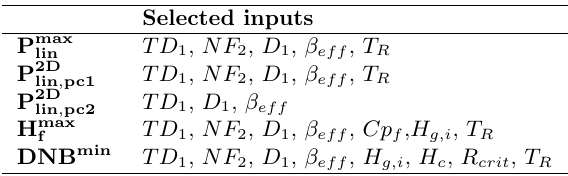
Table B.3. Screening results for IBE coupling.